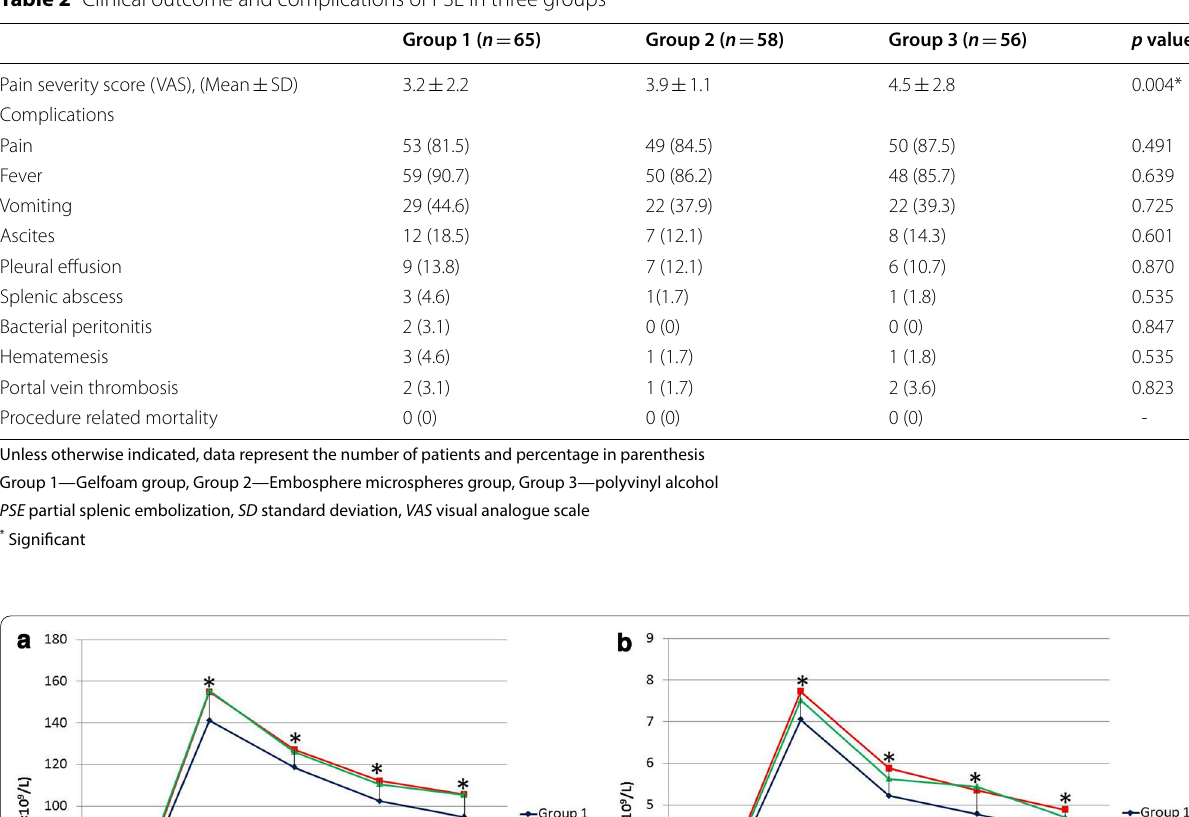
Table 2 Clinical outcome and complications of PSE in three groups